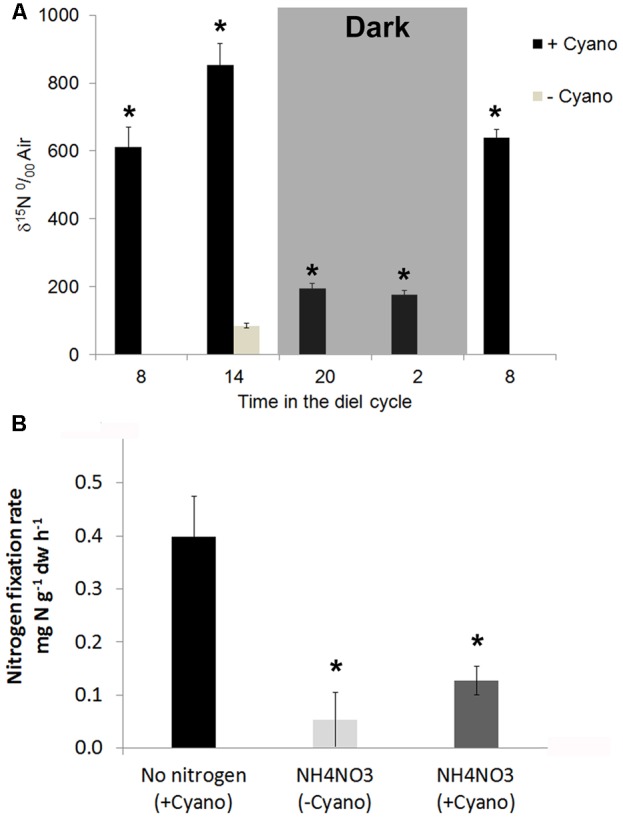
15N2 fixation during the diel cycle and after acclimation to 2 mM NH4NO3. (A) Raw 15N enrichment after 2 h exposure to 15N2 averaged for the time points 8, 14, 20, and 2h during the diel cycle. Ferns were on SAM without nitrogen, the 12 h day started at 6 h. Temperature was kept a constant 21°C. Ferns with N. azollae (+Cyano, black) and without (–Cyano, light gray). (B)
15N2-fixation rates averaged over 2 h at the timepoint 14 h in the diel cycle after a week acclimation on SAM without [No nitrogen (+Cyano), black and with 2 mM NH4NO3 (NH4NO3 (+Cyano), dark gray]; control ferns without N. azollae [NH4NO3 (–Cyano), light gray]. Standard deviations with n = 3. T-test significance marked with ∗ was P < 0.05 for +Cyano data points with reference to ferns –Cyano on SAM for (A); and with reference to +Cyano ferns on no N in (B).